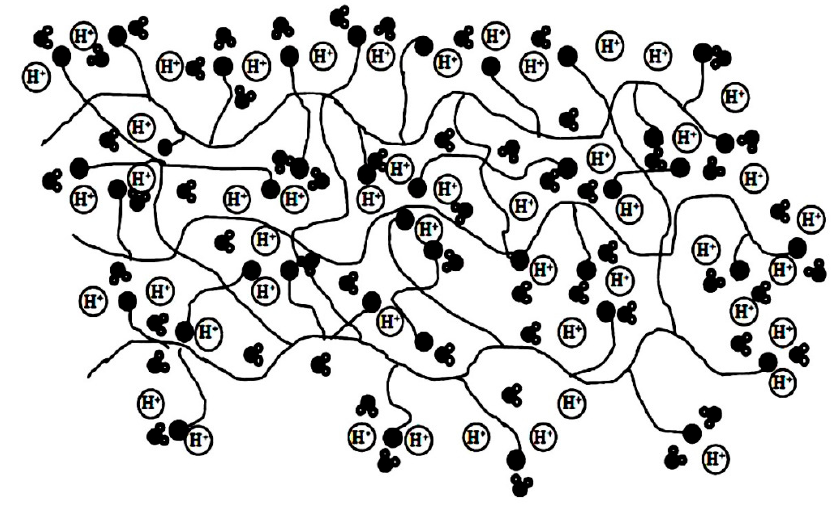
Figure 19. Illustration of the hybrid structure simulating the protons transfers. Reproduced with permission from [124]. Copyright Elsevier, 2015.